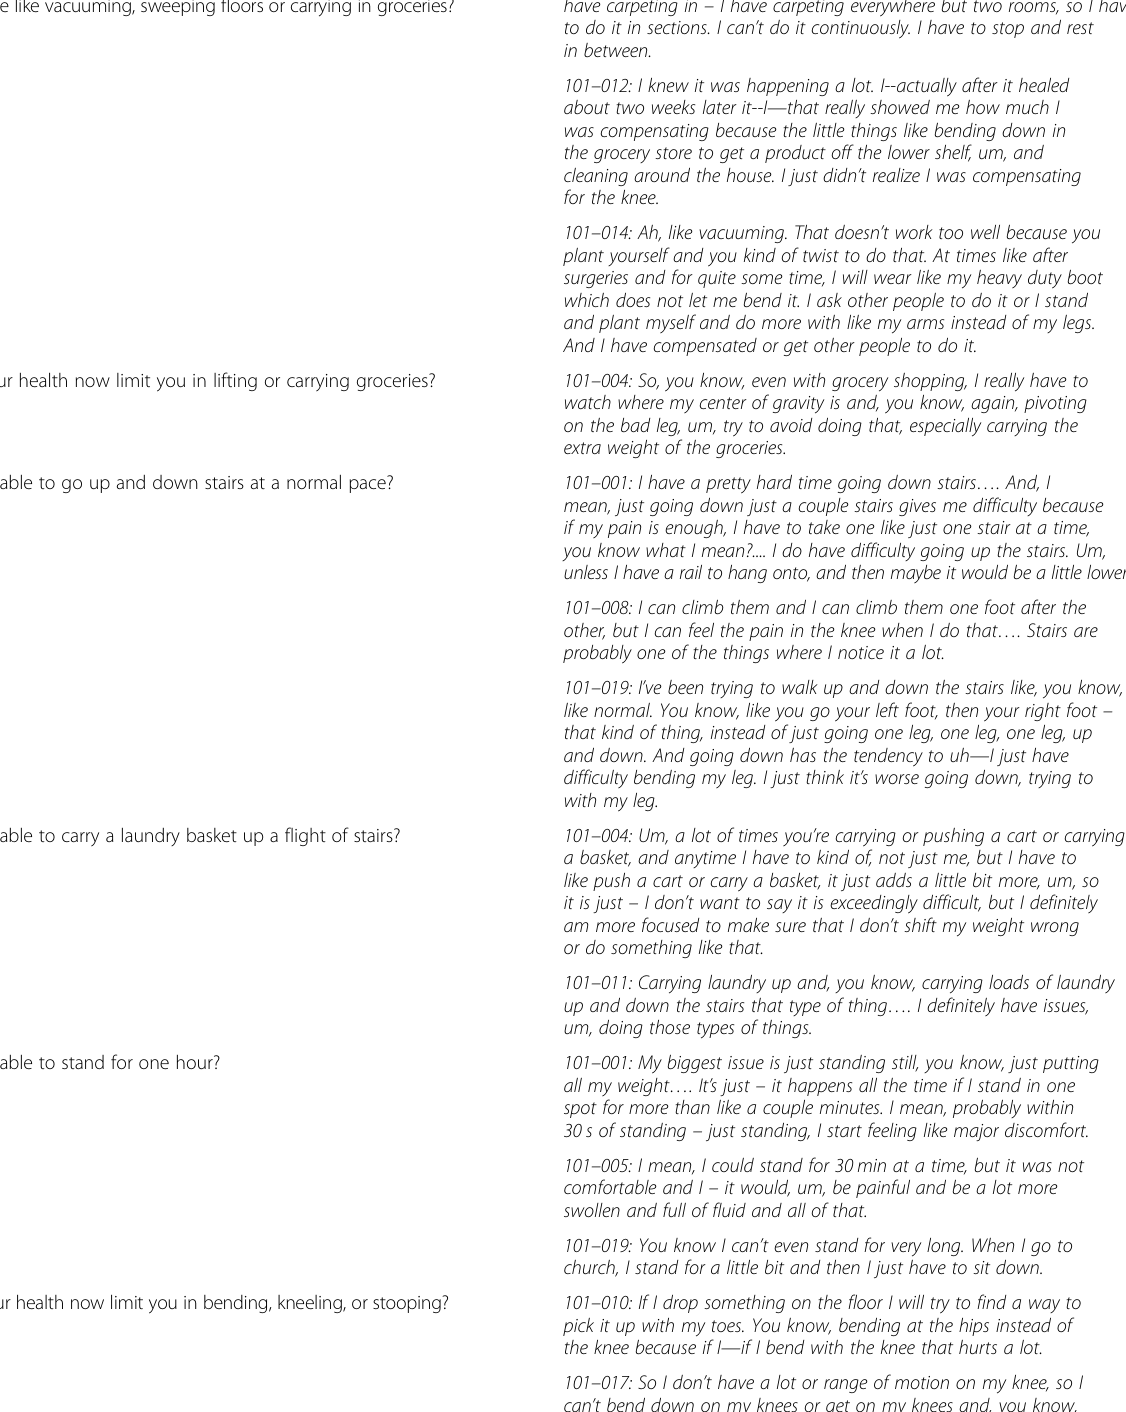
Table 1 Selected patient quotes targeting PROMIS-PF item concepts